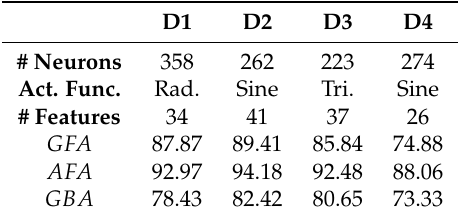
Table 4. Results for the best Global Byte Accuracy ( GBA ) pareto-optimal